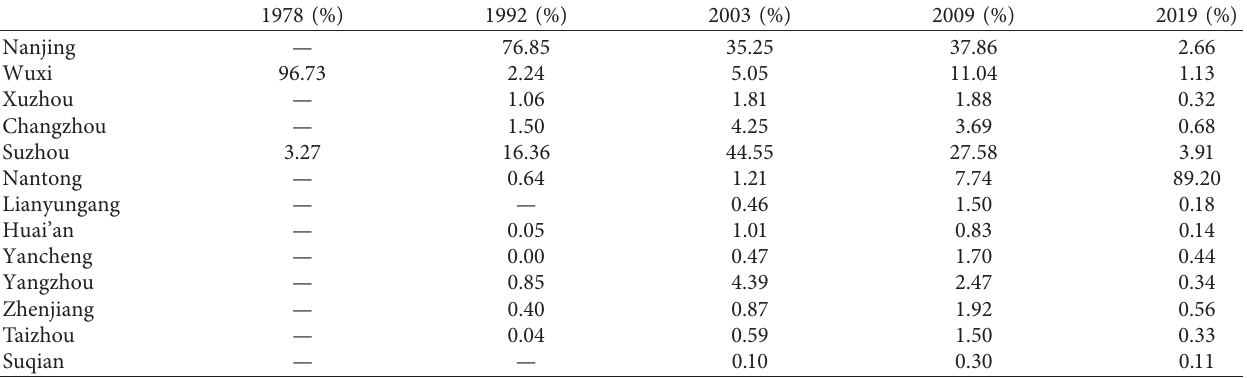
Table 5: Proportion of enterprise investment in cities in Jiangsu Province.